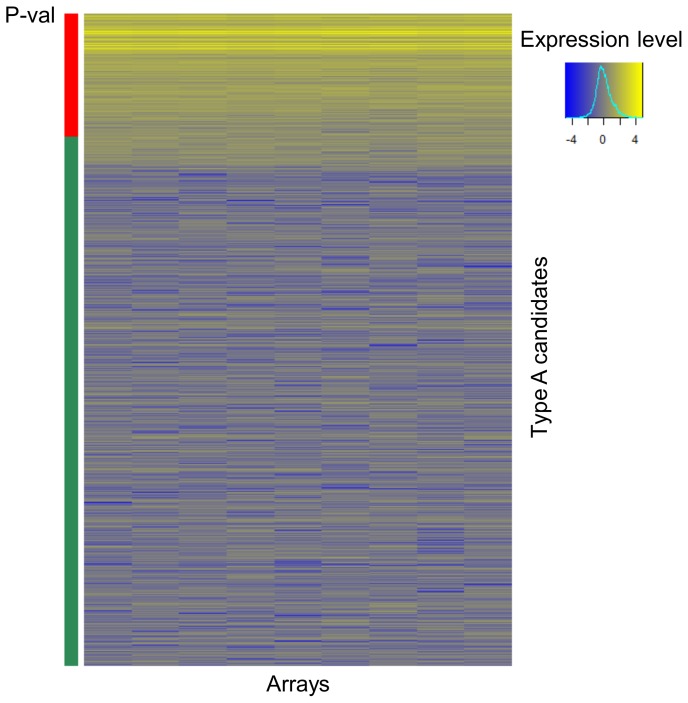
Heat-map representing the expression profiles of microarrays.As positive controls we used reference sigA, rrs and the short ribosomal 5S RNA. Normalized control genes showed a mean expression level of 7.16±1.57. Expression level: yellow to blue (highly expressed to lowly expressed). Statistics: red = p-value <0.05; green = p-value >0.05.